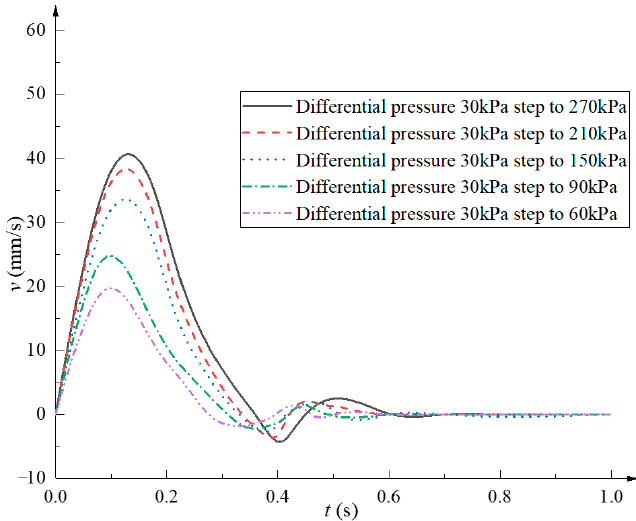
Figure 8. Valve core speed dynamic characteristic curve.